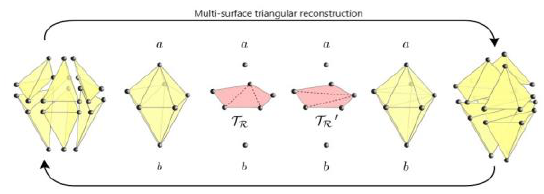
Figure 11 . Illustration of a triangular reconstruction of a